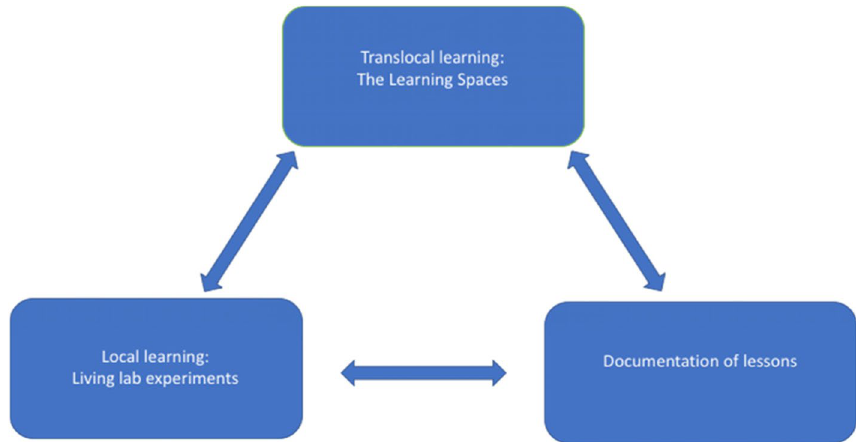
Fig. 3 The learning cycle enabled by the meta-lab